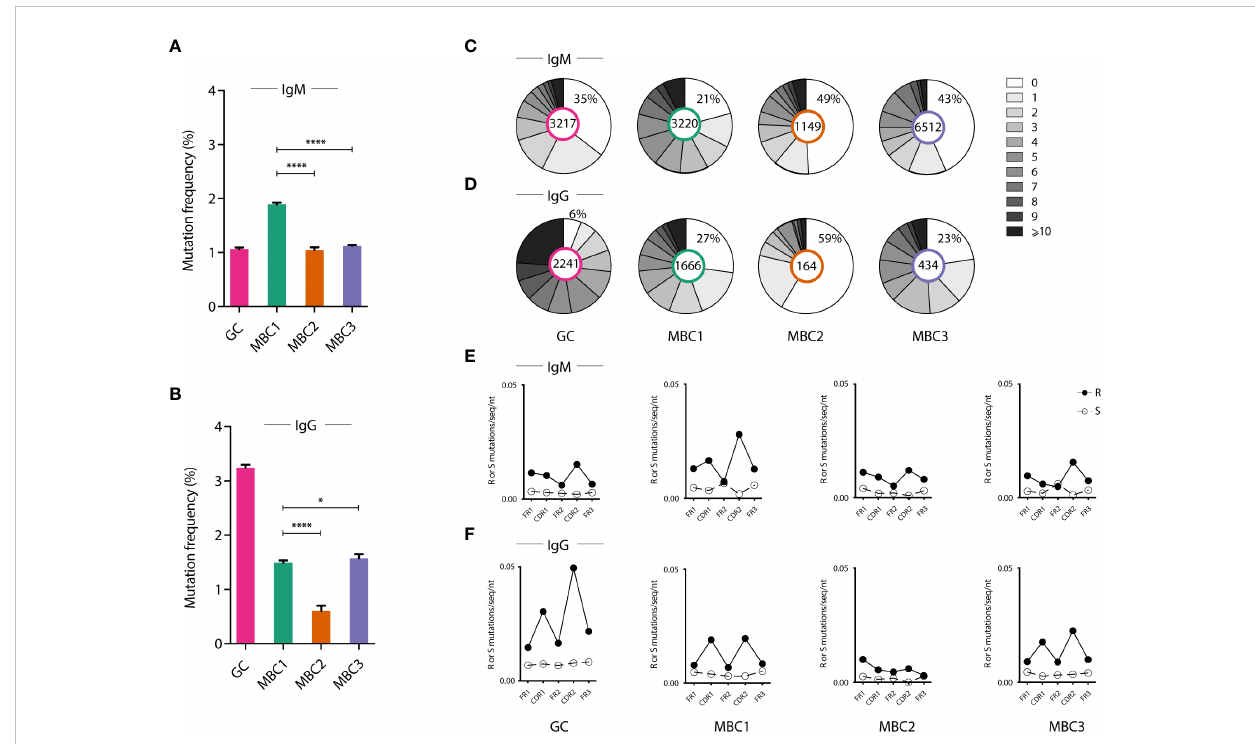
FIGURE 3 Mutation frequency in the different MBC subsets. (A – F) Ig heavy chain sequencing analysis from sorted GC B cells and MBC subsets. (A, B) Graphs show the frequency of somatic mutations in indicated cell populations in IgM (A) and IgG (B) expressing cells. (C, D) Pie charts show the number of mutations in indicated cell populations in IgM (C) and IgG (D) expressing cells. (E, F) Graphs show the mutation pattern with replacement (R) and silent (S) mutations along the Ig molecule (framework regions and CDRs) in IgM (E) and in IgG (F) . Results from a pool of 6 mice. *P < 0.05; ****P <